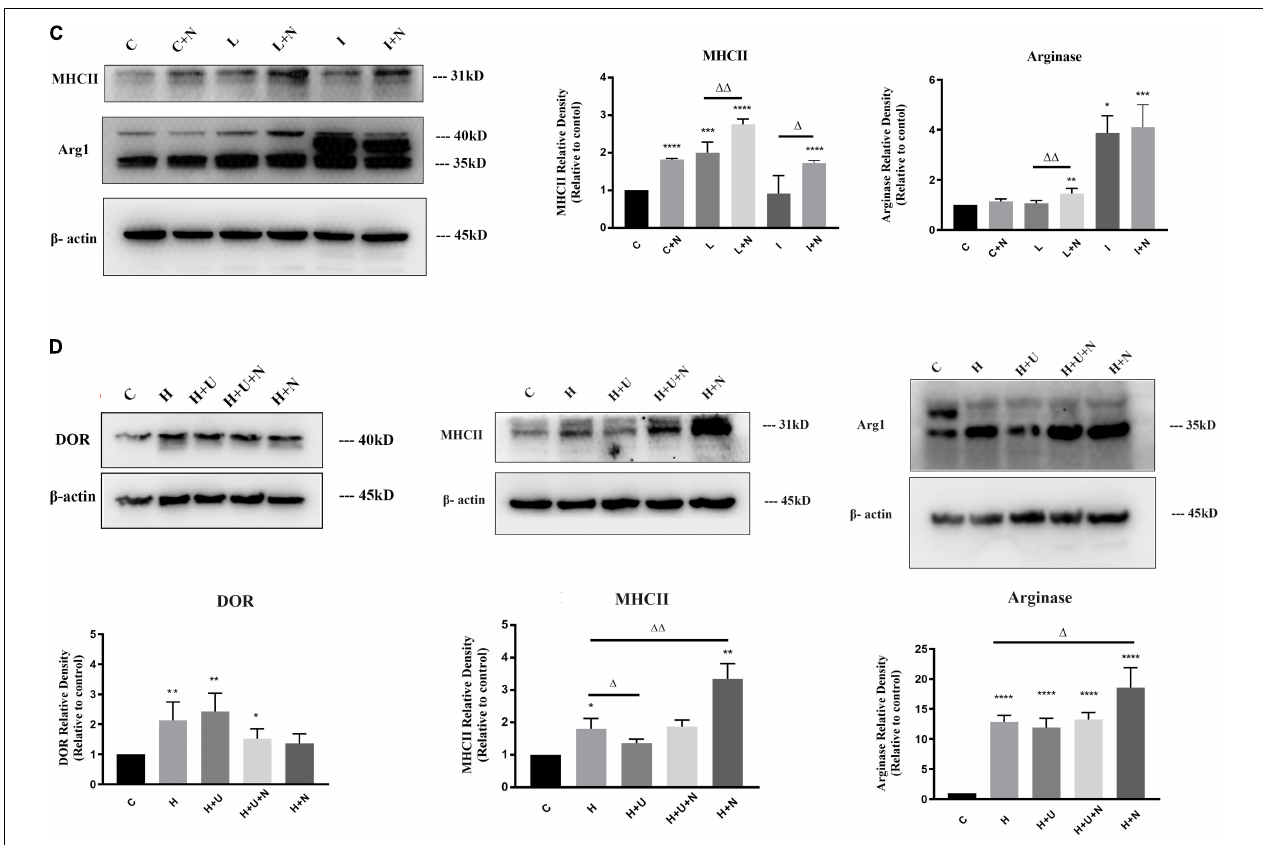
FIGURE 2 | Effects of δ -opioid receptor (DOR) activation on microglial M1 transformation in LPS or hypoxic insult, and microglial M2 transformation under IL4 condition. The expression levels of DOR, MHCII and Arginase were examined by Western blot in BV2 cells at different states ( N ≥ 3 in each group). C: control. C + U: DOR activation by UFP-512 under normal condition. C + N: DOR inhibition by naltrindole normal condition. L: LPS. L + U: UFP-512 plus LPS. L + N: naltrindole plus LPS. I: IL4. I + U: UFP-512 plus IL4. I + N: naltrindole plus IL4. H: hypoxia. H + U: DOR activation by UFP-512 under hypoxic insults. H + U + N: UFP-512 plus naltrindole under hypoxic insults. H + N: DOR inhibition by naltrindole under hypoxic insult. (A) DOR-induced inhibition of MHCII expression under normal condition and LPS insult. ** p < 0.01, *** p < 0.001, **** p < 0.0001 vs. C; (cid:49)(cid:49) p < 0.01 vs. L. Note that the administration of UFP-512 did not appreciably change the expression level of DOR in BV2 cells, but DOR activation significantly downregulated MHCII under normal condition and LPS insult. (B) Effect of DOR activation on arginase in BV2 cells. * p < 0.05, ** p < 0.01, **** p < 0.0001 vs. C; (cid:49)(cid:49) p < 0.01 vs. L. Note that 5–20 µ M UFP-512 did not cause an appreciable change in arginase under normal condition and LPS insult, but the 20 µ M of UFP-512 significantly reduced arginase protein in the BV2 cells exposed to IL4. (C) Effects of DOR inhibition on MHCII and arginase in BV2 cells. * p < 0.05, ** p < 0.01, *** p < 0.001, **** p < 0.0001 vs. C; (cid:49)(cid:49) p < 0.01 vs. L; (cid:49) p < 0.05 vs. I. Note that the application of naltrindole largely upregulated MCHII under normal condition, LPS insult and IL4 insult. DOR inhibition significantly increased arginase protein under LPS insult. (D) Effects of DOR activation on BV2 activation in hypoxic stress. The BV2 cells were exposed to hypoxic environment, UFP-512 and naltrindole were simultaneously or separately applied to these cells for 48 h. * p < 0.05, ** p < 0.01, **** p < 0.0001 vs. C; (cid:49) p < 0.05, (cid:49)(cid:49) p < 0.01 vs. H. Note that hypoxia induced an upregulation of DOR in BV2 cells, while DOR activation or inhibition did not change the level of DOR in a major way. The applications of UFP-512 largely inhibited MHCII